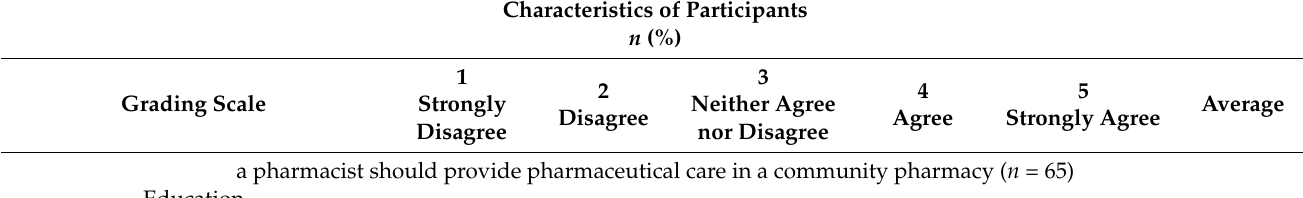
Table 6. Nurses’ future expectations in the field of cooperation with a pharmacist in detail. Characteristics of